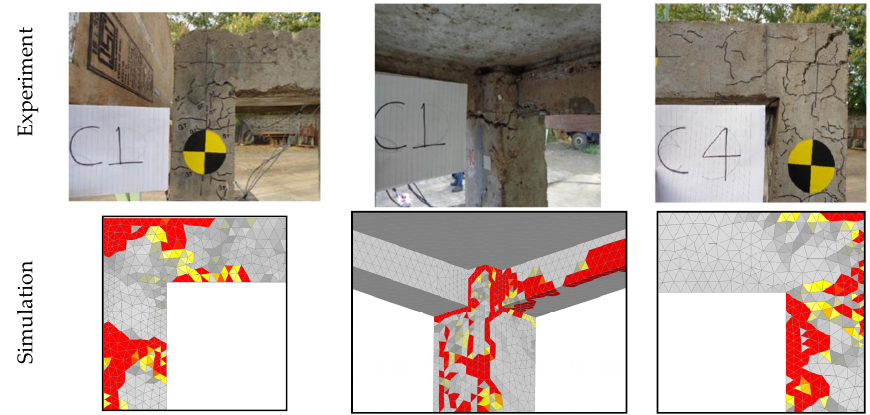
Figure 9. Numerically calculated temperature distributions in: ( a ) beams and ( b ) columns.